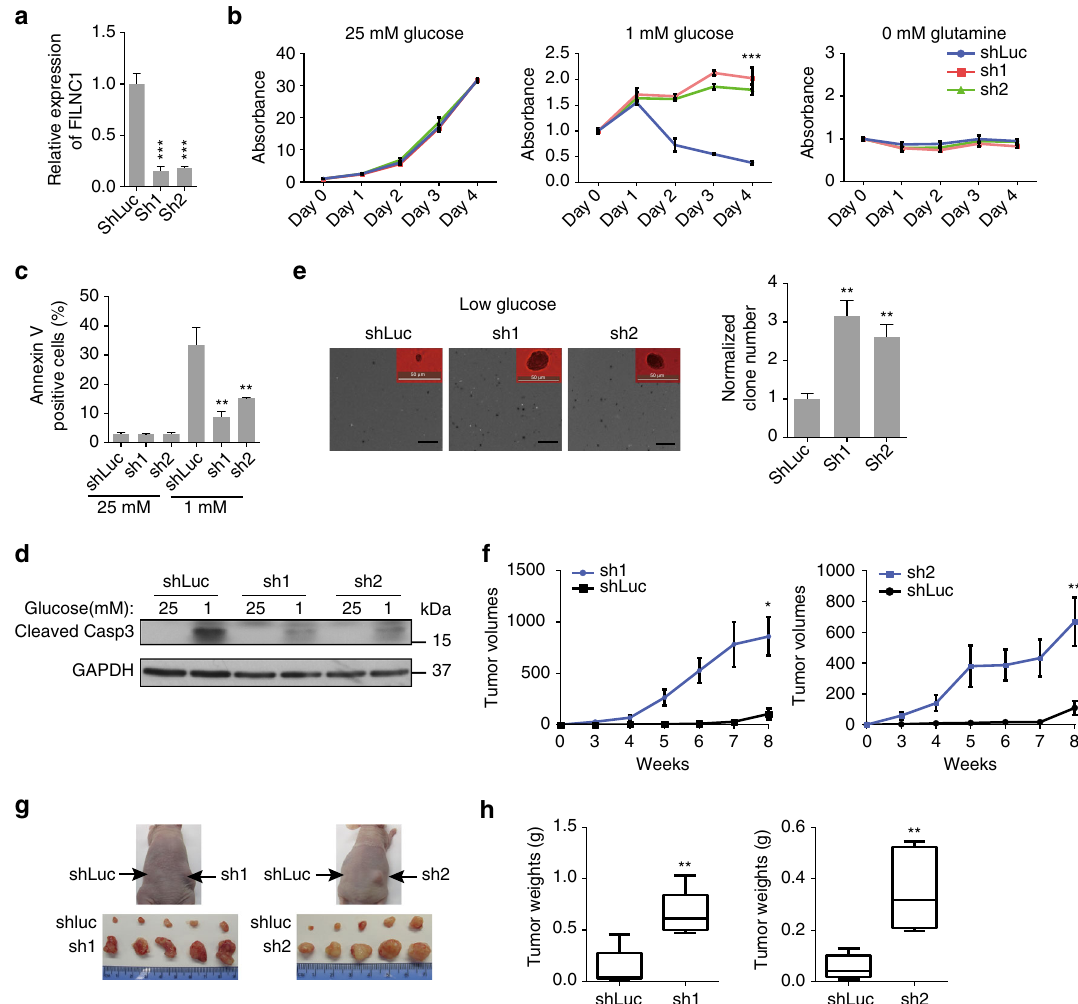
Fig. 2 FILNC1 de fi ciency alleviates energy stress-induced apoptosis and promotes renal tumor development. a Bar graph shows FILNC1 shRNA-mediated knockdown ef fi ciency in 786-O cells. b 786-O cells infected with either control shRNA or FILNC1 shRNA were cultured in various medium for different days as indicated, and then subjected to cell proliferation analysis. c , d Control shRNA or FILNC1 shRNA-infected 786-O cells were cultured in 25 or 1 mM glucose-containing medium for 24 h, then subjected to Annexin V/PI staining followed by FACS analysis to measure the percentages of apoptotic (Annexin V-positive cells/PI-negative cells) or necrotic cells (Annexin V-positive cells/PI-positive cells) ( c ), or to Western blotting analysis to measure Caspase-3 cleavage ( d ). e 786-O cells infected with either control shRNA or FILNC1 shRNA were seeded in soft agar containing 5 mM glucose. The left images show the images of representative soft agar colonies ( Scale bars represent 50 μ m and 1.5 mm, respectively). The right bar graph shows the relative colony numbers from the soft agar assay (mean ± s.d., n = 5 fi elds per group, each fi eld was assessed from an independent experiment, two-tailed Student ’ s t - test). f Tumor volumes of 786-O xenograft tumors infected with either control shRNA or FILNC1 shRNA at different weeks after injection. (mean ± s.e.m, n = 5 xenograft tumors, two-tailed Student ’ s t -test). g , h The representative images ( g ) and tumor weight ( h ), mean ± s.d, n = 5 xenograft tumors, two-tailed Student ’ s t -test) of different tumor groups at the endpoint. All values, unless otherwise noted, represent mean ± s.d. from three independent experiments, two-tailed Student ’ s t -test. * P < 0.05; ** P < 0.01; *** P < anchorage-independent growth, as revealed by increases in both The above data prompted further examination of FILNC1 func- colony size and number, under glucose starvation condition (Fig. 2e). In line with the data from in vitro analyses, our in vivo cancer cells. We identi fi ed two independent shRNAs that could experiments using the xenograft model showed that FILNC1 de fi ciency promoted renal tumor development and markedly increased tumor size and weight at the endpoint (Fig. 2f – h).